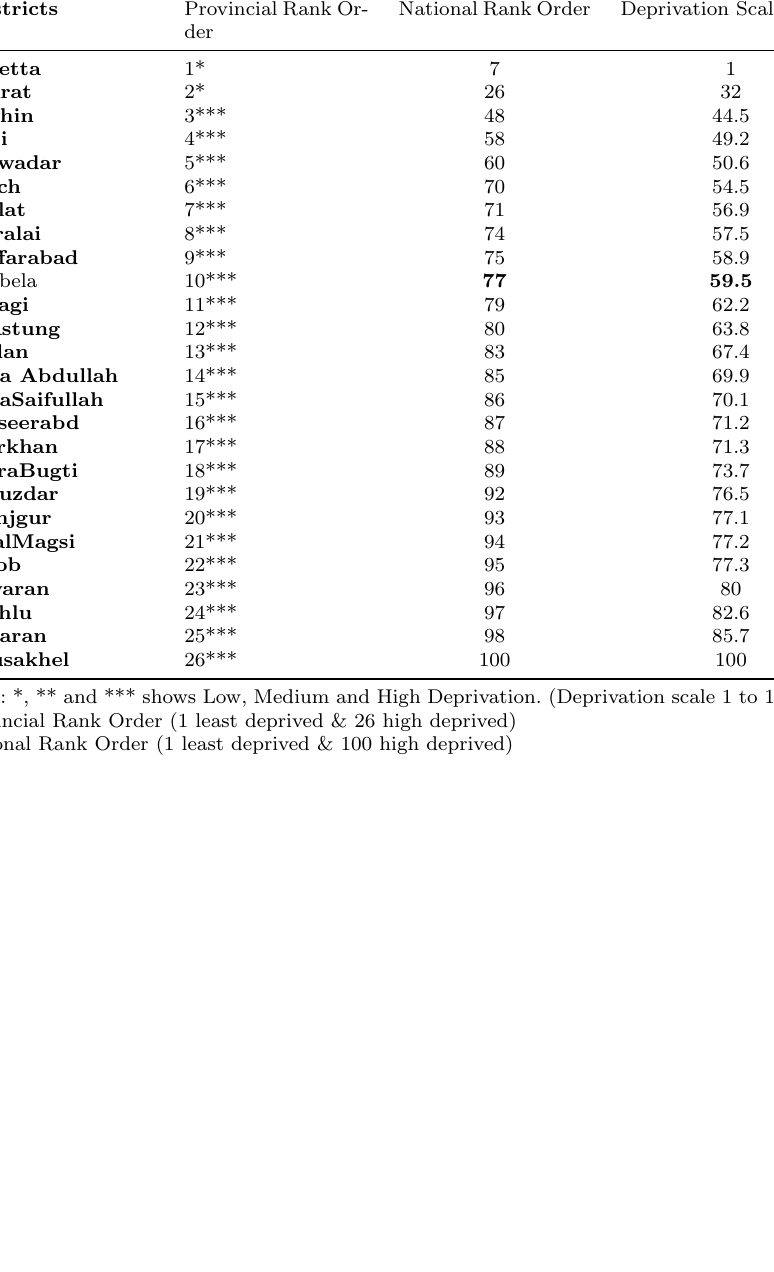
National Rank Order